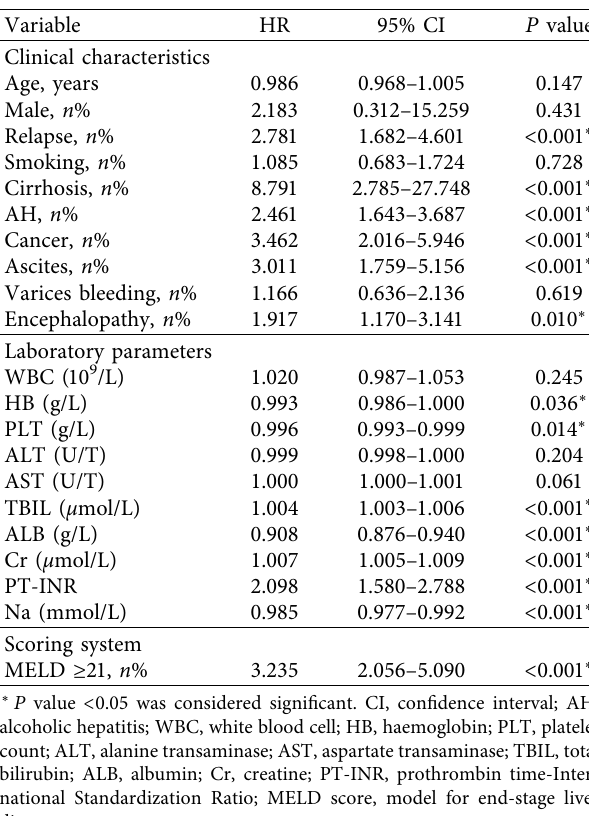
Table 2: Univariable analysis of ALD patients in the training